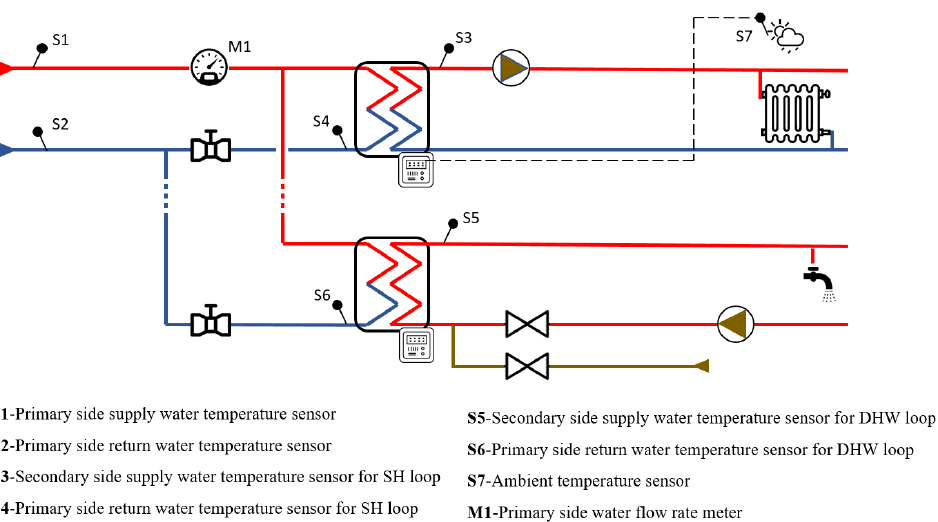
Figure 1. Schematic view of a typical substation, from Danfoss-ECL Comfort 310.